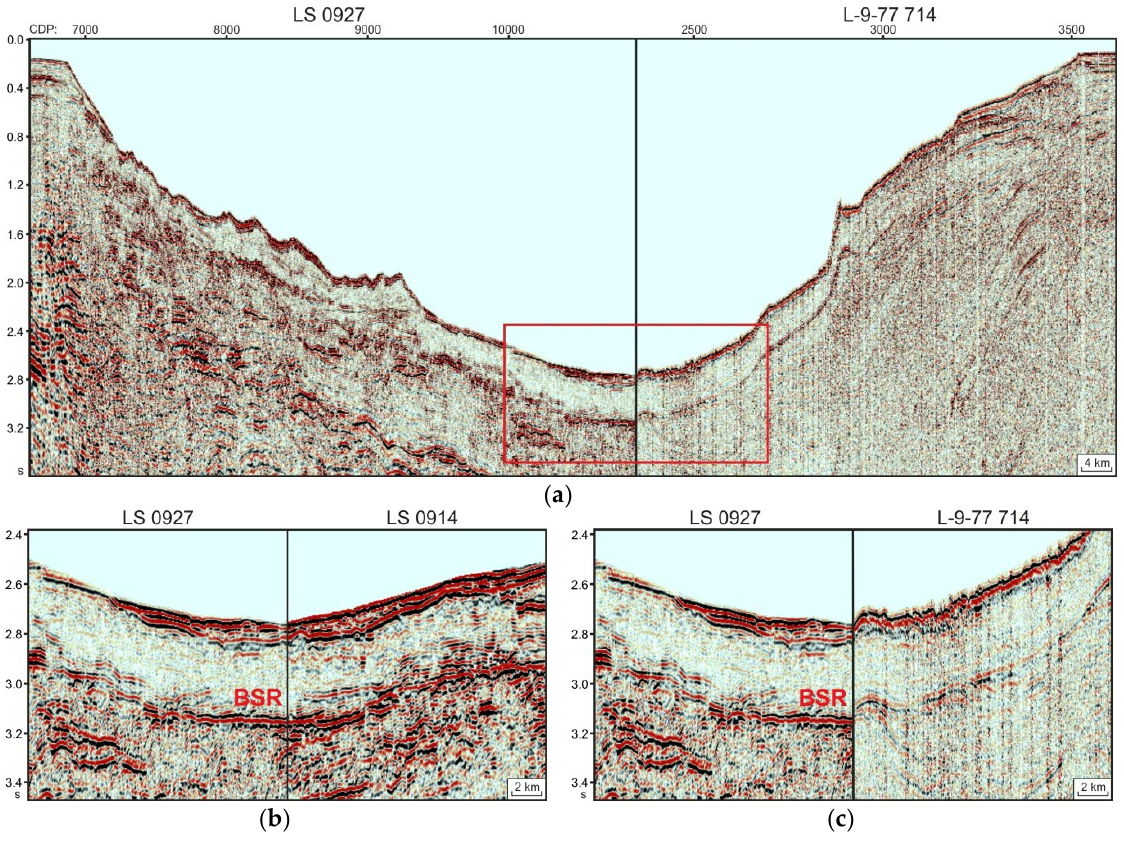
Figure 9. Results of joining seismic sections from the Laptev Sea (LS0927 and LS0914) and the Beaufort Sea (L-9-77 714): ( a ) regional sections LS0927 and L-9-77 714; ( b , c ) enlarged fragments of sections LS0927 and LS0914 ( b ), LS0927 and L-9-77 714 ( c ).